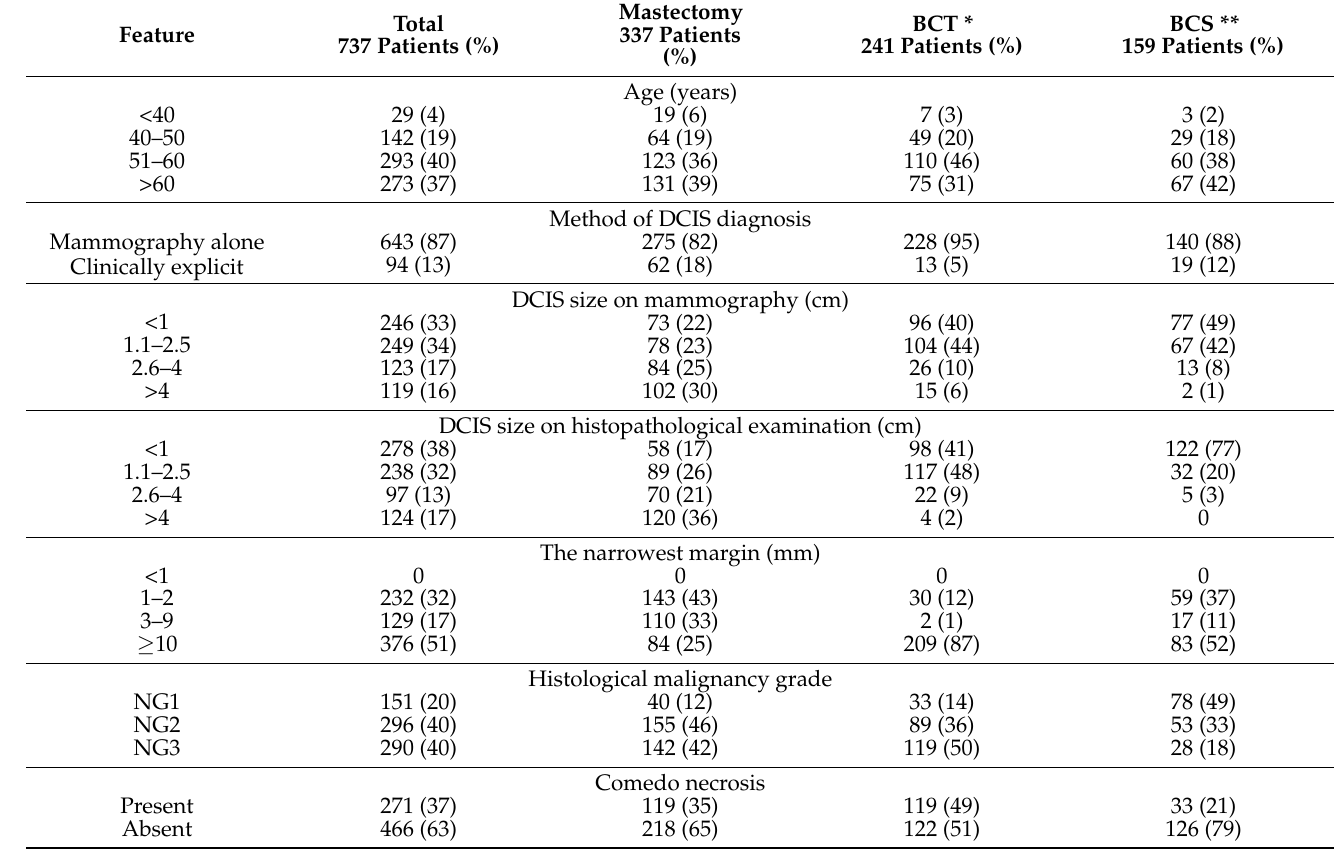
Table 1. Characteristics of 737 consecutive patients with DCIS, with subdivision into the methods of treatment.